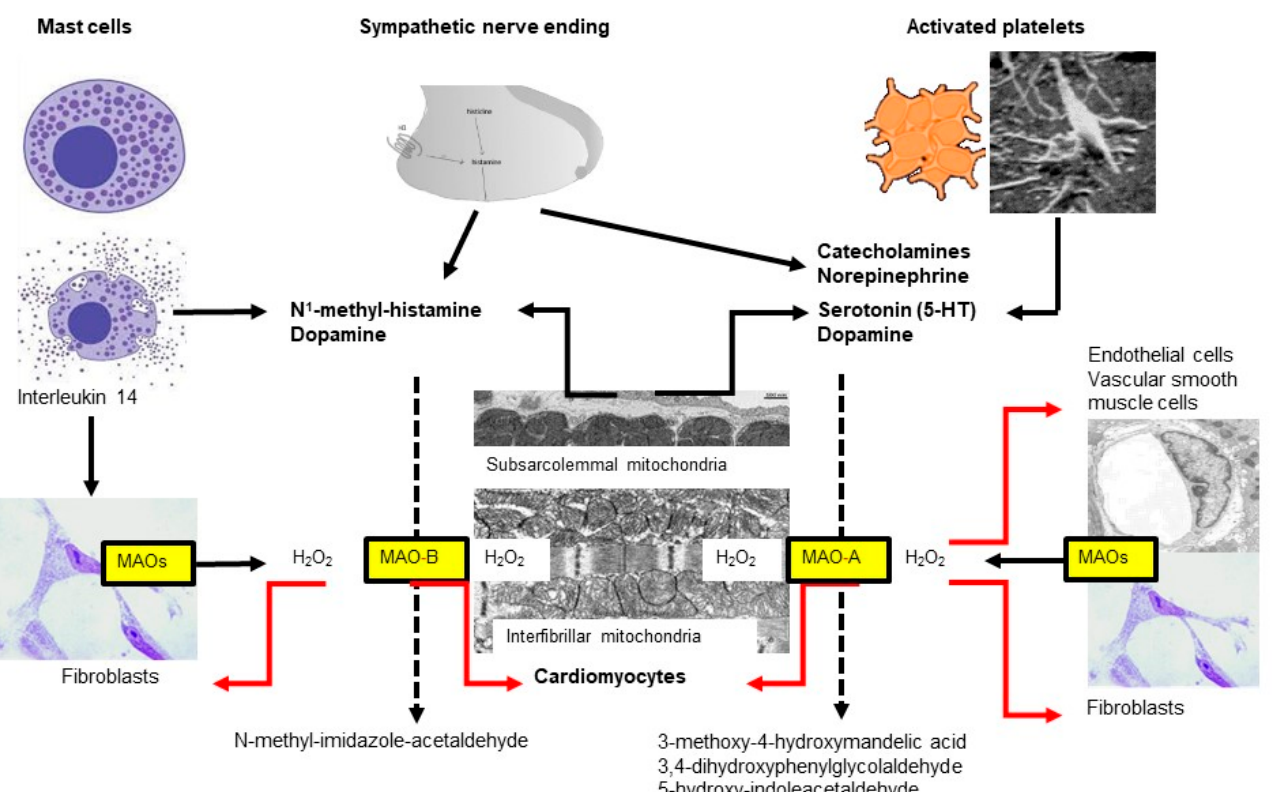
Figure 2. Two subtypes of monoamine oxidases (MAO)—named A and B—are located at the outer mitochondrial membrane, which differ in their substrate specificity. Almost all cell types express MAOs but the respective subtype might differ between species, organs and age. In the heart, MAOs are expressed in cardiomyocytes, fibroblasts, vascular smooth muscle and endothelial cells. In the heart, MAO substrates are derived from different sources including mast cells, sympathetic nerves, platelets and cardiomyocytes.